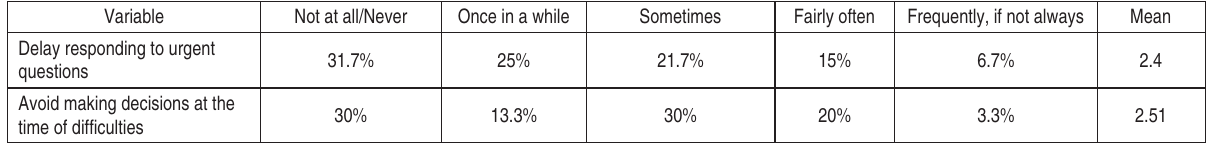
Table 4. Laissez-faire leadership styles of the manager/supervisor